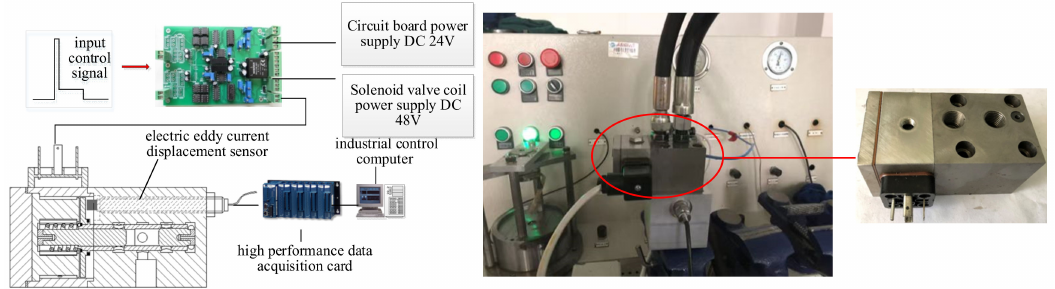
Figure 5. Solenoid valve test